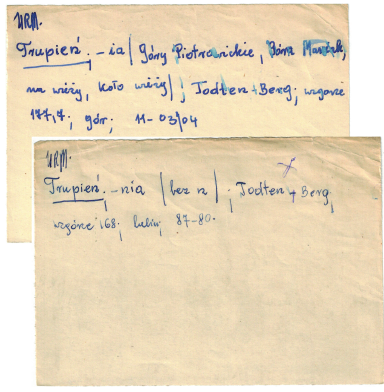
Figure 2. Cards about Trupie´n from the manually edited alphabetical card index ( left ) and the corresponding dictionary entry, as published in the sixteenth volume of SENG´S ( right